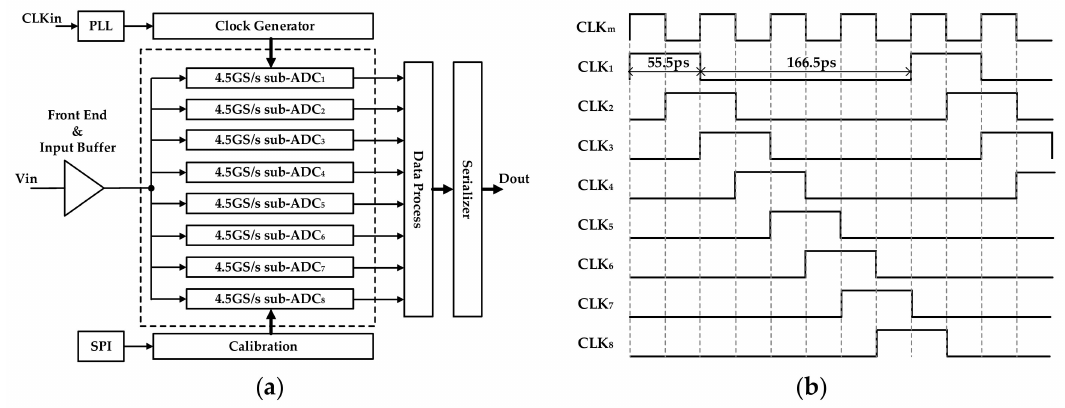
Figure 1. ( a ) Overall architecture and ( b ) overall timing diagram of the proposed